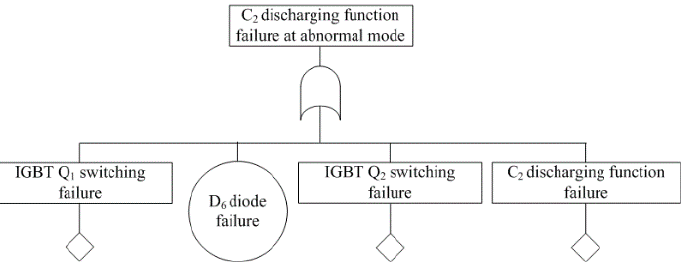
Figure 11. Sub fault tree for C 2 discharging function failure at normal mode.